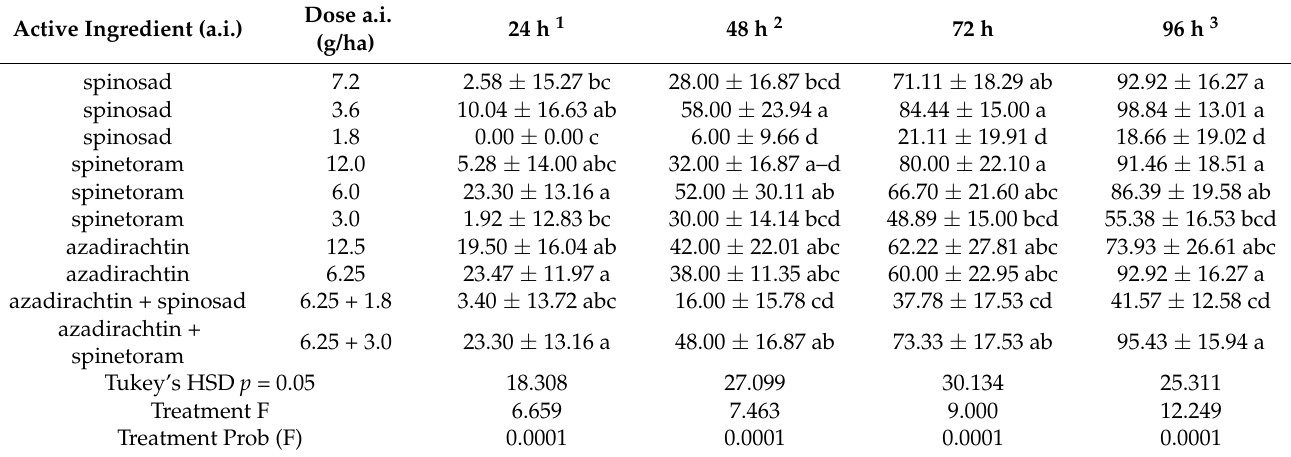
Table 3. Efficacy (%) of insecticides ( ± SE) on Colorado potato beetle larvae over the course of the laboratory trial. Active Ingredient